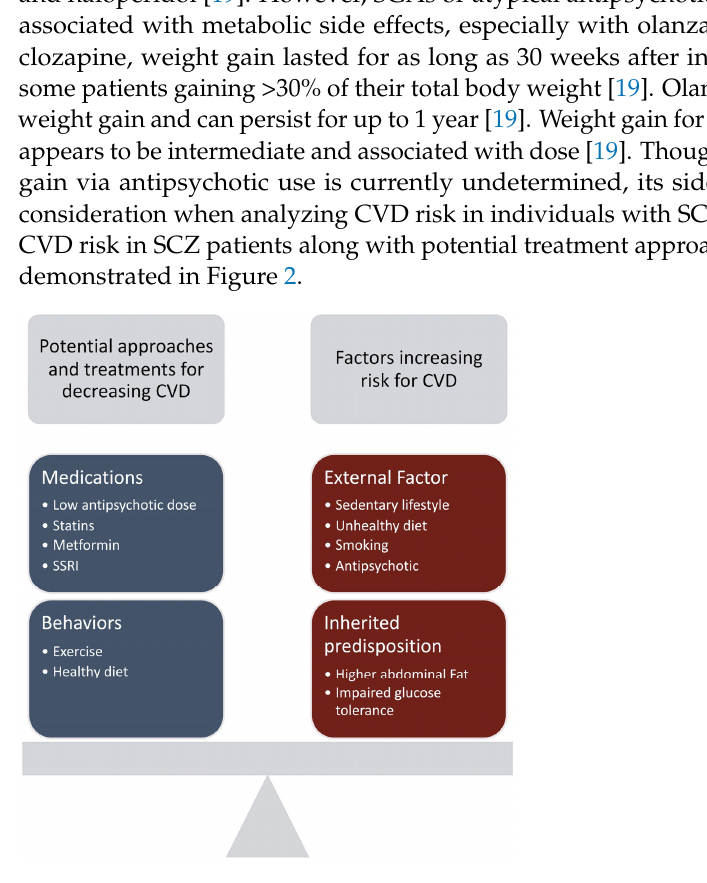
Figure 2. Cardiovascular risk factors and treatment alternatives for patients with schizophrenia (SCZ). The two blocks on the left represent potential approaches to treat and prevent cardiovascular disease (CVD) for patients with SCZ. Blocks on the right represent factors that increase the risk for CVD in patients with SCZ.